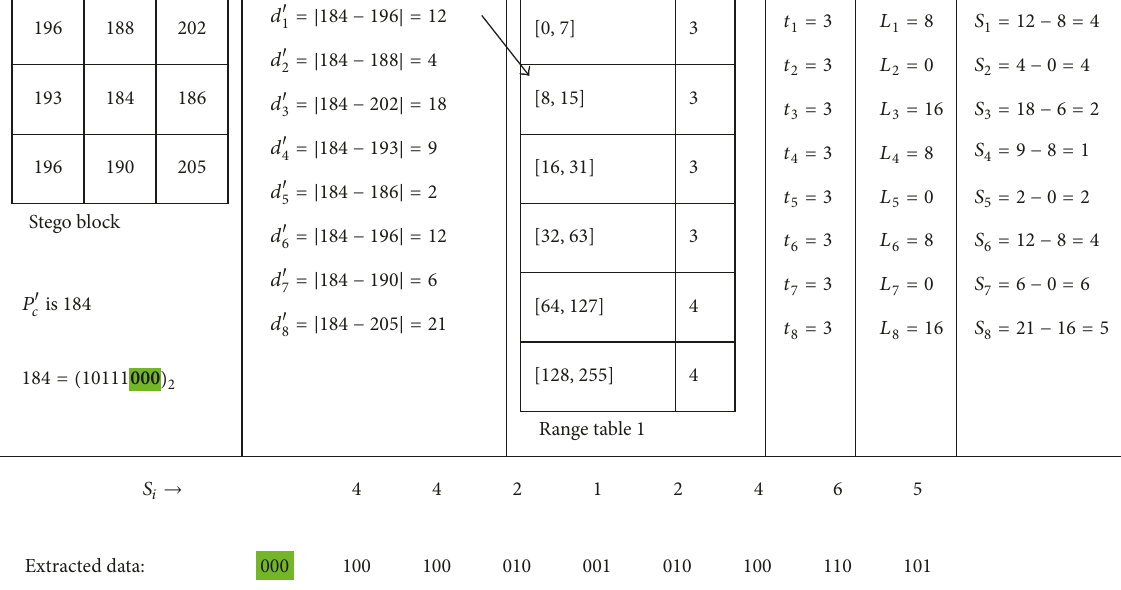
Figure 3: Example of extraction.